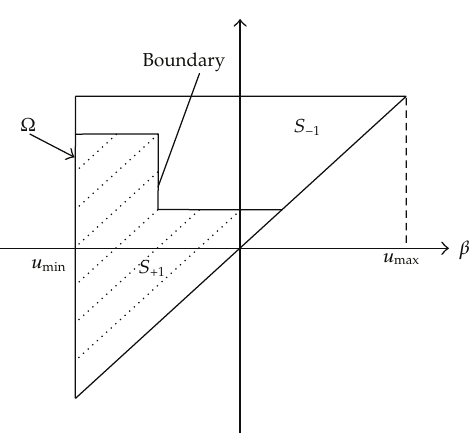
Figure 3: Geometrical representation of Preisach (cid:2) α - β (cid:3)